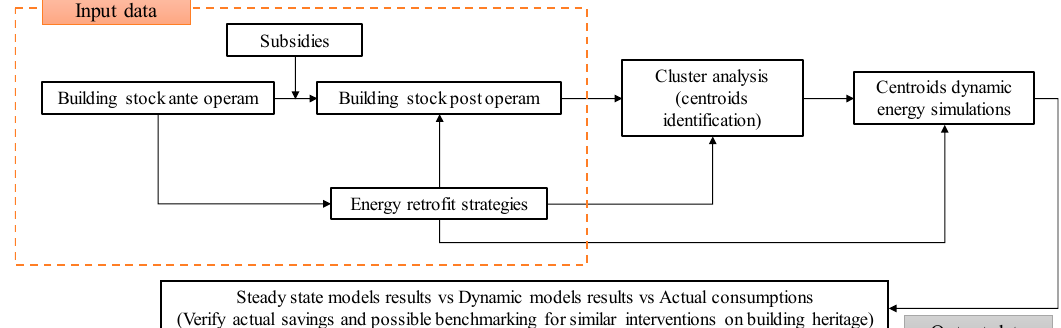
Figure 10. Methodology flow chart.